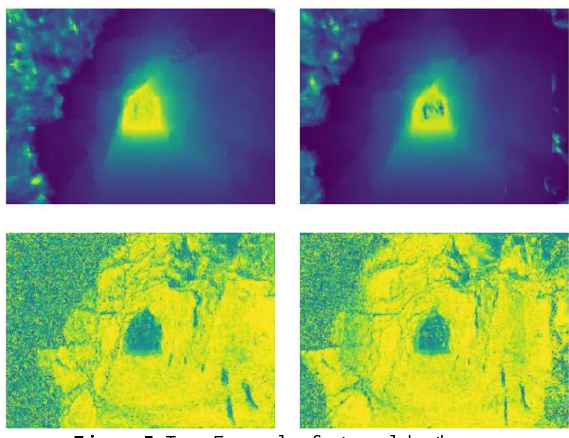
Figure 5. Top: Example of a tunnel depth map, Bottom: Example of a tunnel confidence map.